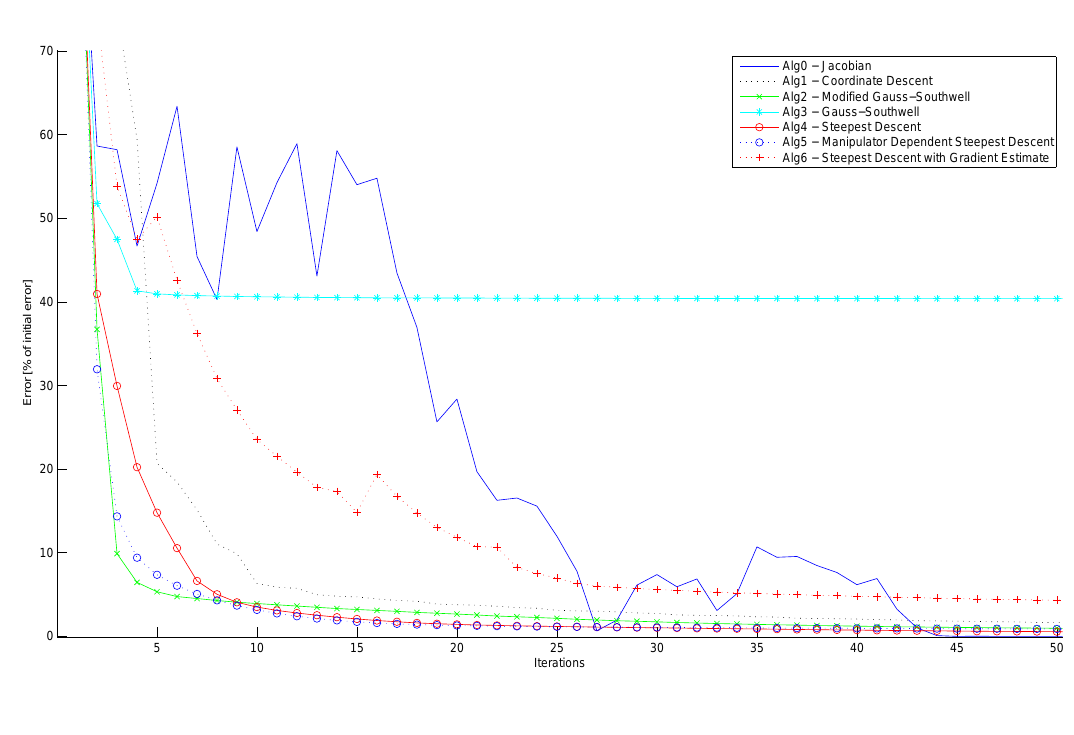
Figure 4: Convergence of algorithms with initial conditions far from a solution.